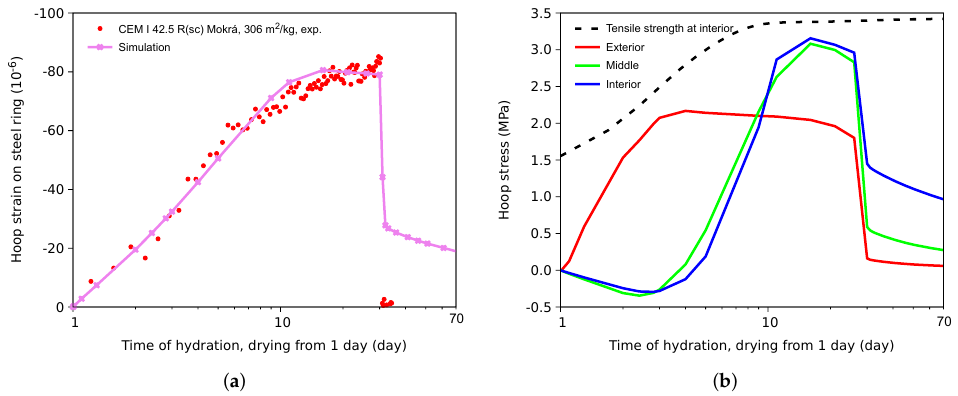
Figure 12. Hoop strain on the steel ring ( a ) and hoop stress on the mid-plane in the vicinity of the artificial shallow notch ( b